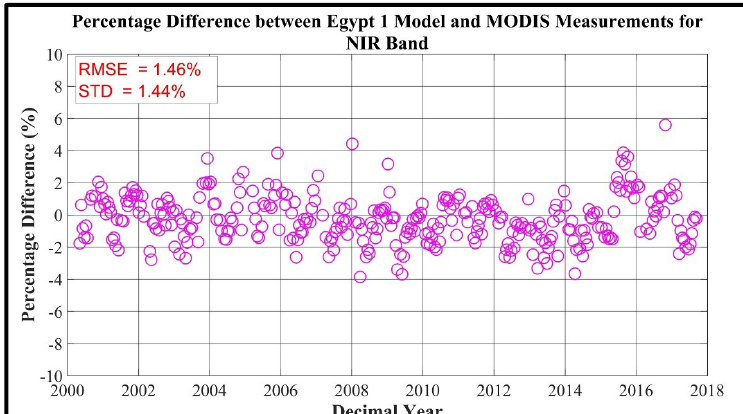
Figure 8. Comparison between Egypt 1 Model and MODIS Measurement (band 2).